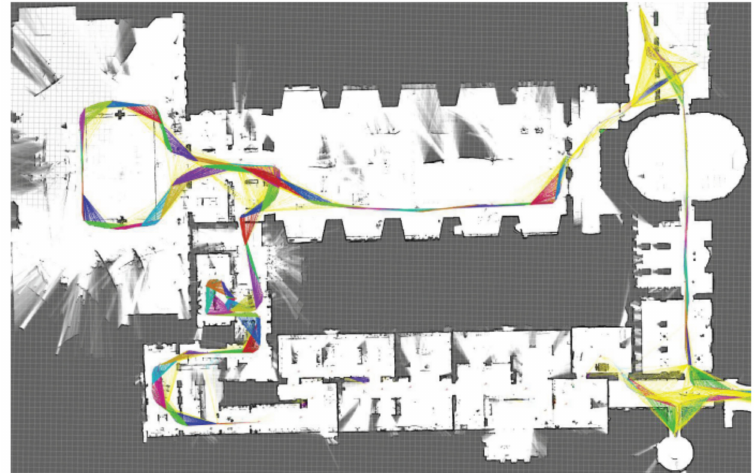
Figure 7. Mapping based on the b0_2014_07_11_11_00_49